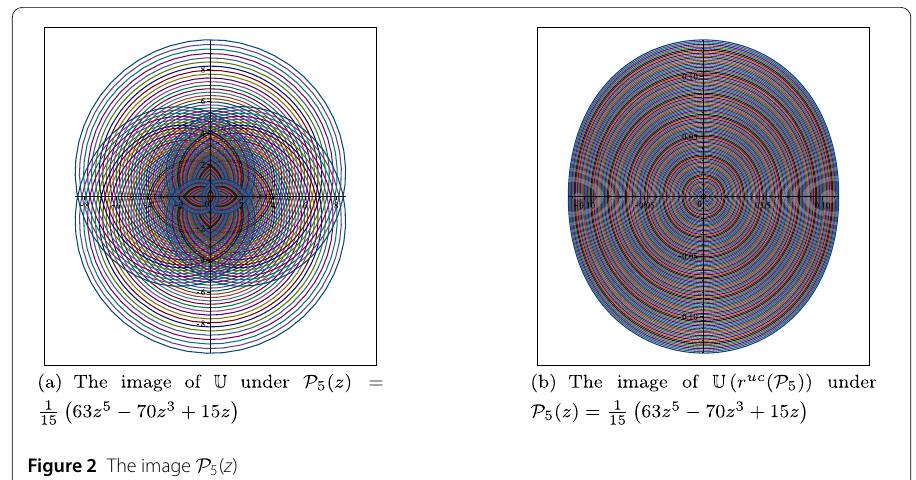
Figure 2 The image P 5 ( z